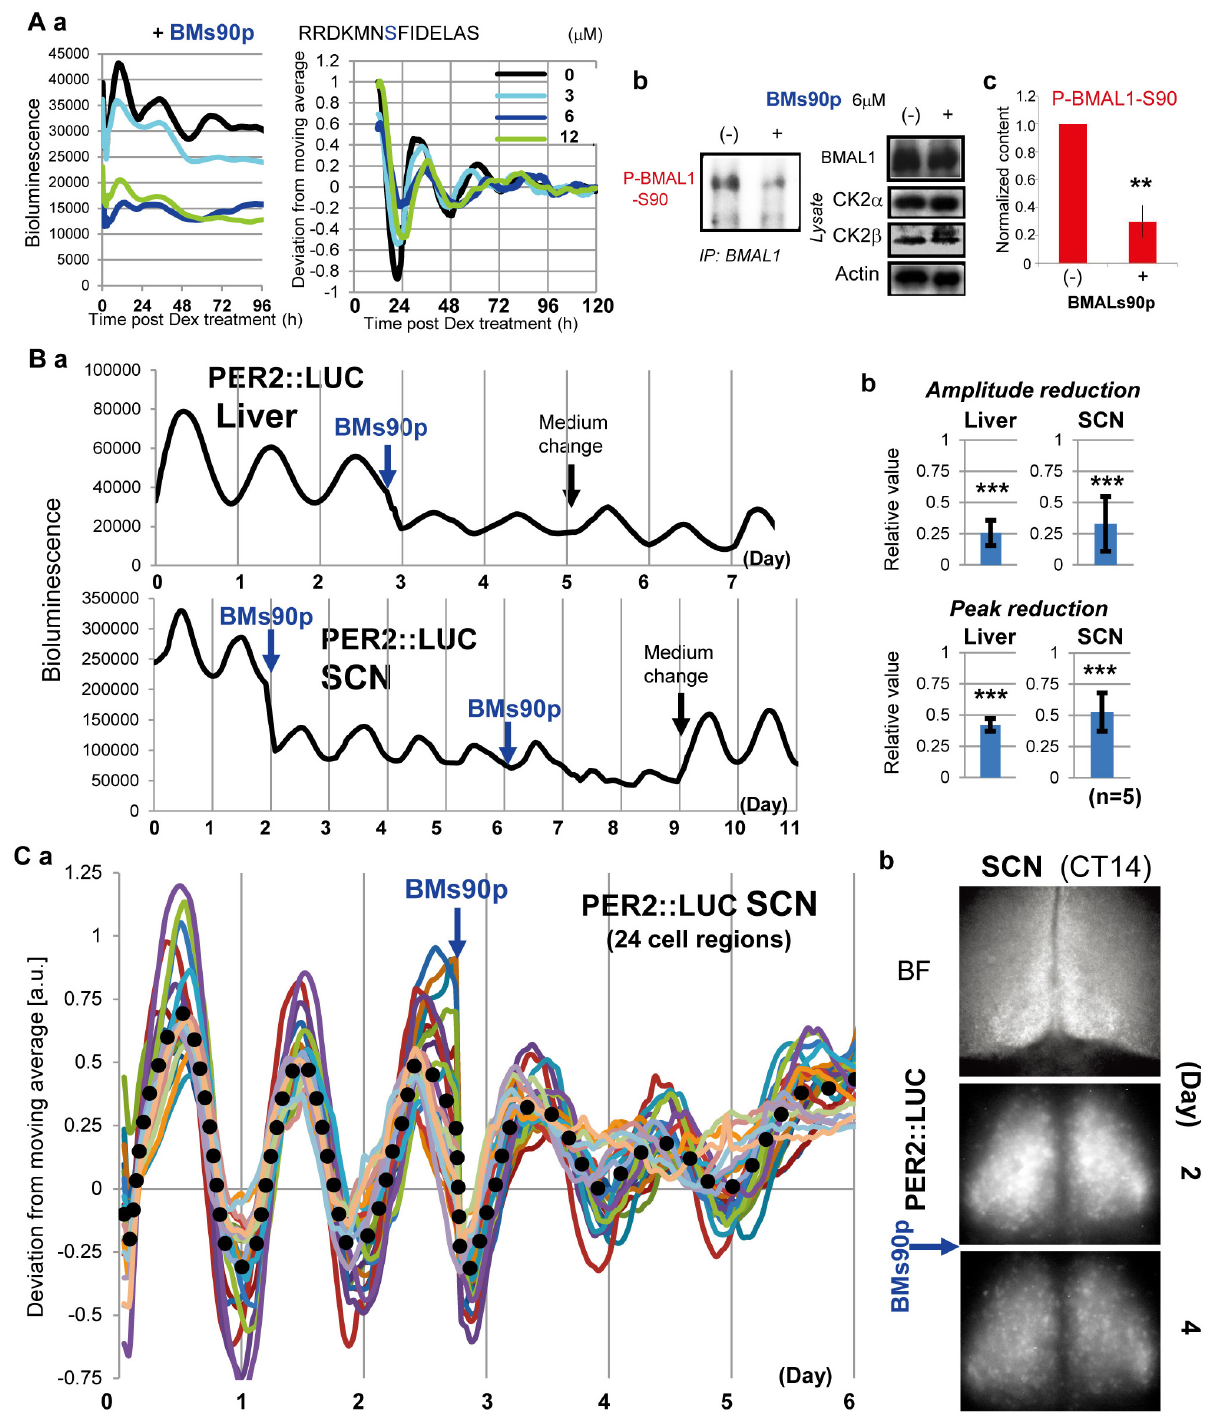
Fig 1. CK2-mediated circadian BMAL1-Ser90 phosphorylation regulates the central and peripheral clocks. (A) Clock performance and BMAL1 phosphorylation in NIH-3T3:Per2L cells after treatment with BMs90p (a 14 amino acid BMAL1 peptide containing S90; concentrations as indicated) for 30 min and subsequent clock-synchronization by dexamethasone (Dex) treatment for 30 min. (a) Cell cultures were monitored for luciferase activity by real-time bioluminescence assay. Representative raw (left) and detrended/averaged (right) profiles are shown ( n = 4). (b) Immunoblot (IB) analysis of BMAL1-immunoprecipitates (IP) and lysates from BMs90p-treated cells for BMAL1, P-BMAL1-S90 (Ser90-phoshorylated BMAL1), CK2 α , CK2 β , and actin (control). Shown are representative images of triplicate experiments. (c) Quantification of P-BMAL1-S90 levels in BMs90p treated cells ( n = 3). Values in